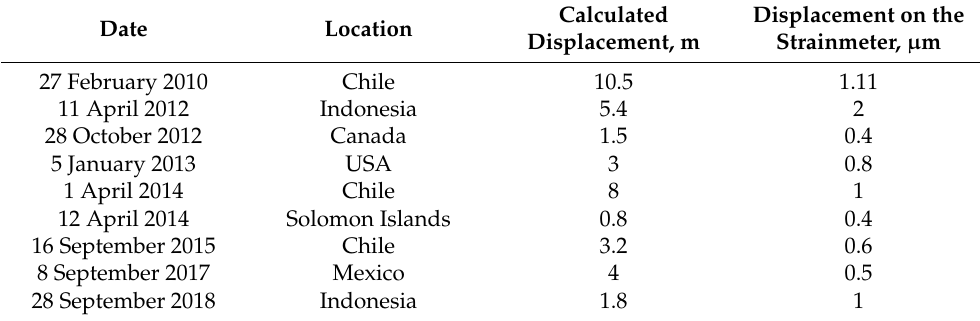
Table 1. Calculated displacements of geoblocks and deformation anomaly values recorded by the laser strainmeter.